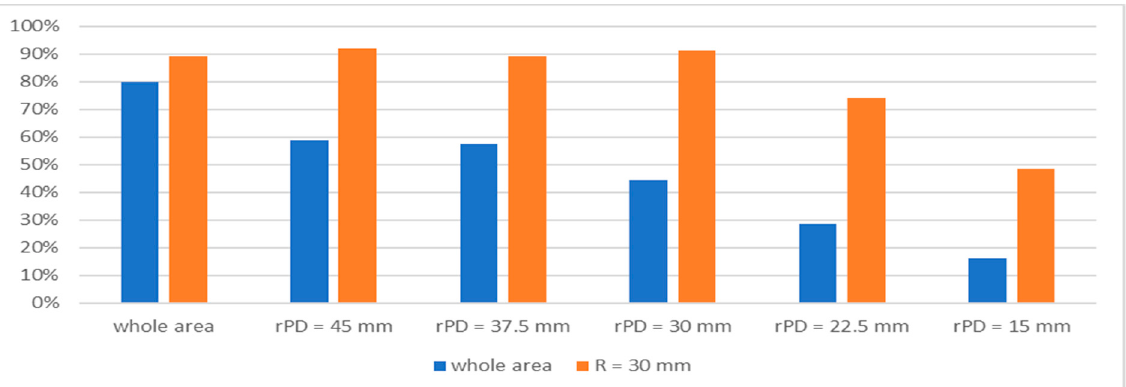
Figure 19. The share of positively matched markers for the entire pattern and in the area of radius R = 30 mm around the center of the marker grid, depending on the size of the area around the center of the images, from which points for image transformation were selected ( r PD —radius of the circle around the center of the marker grid delimiting the area in which matching points were located).